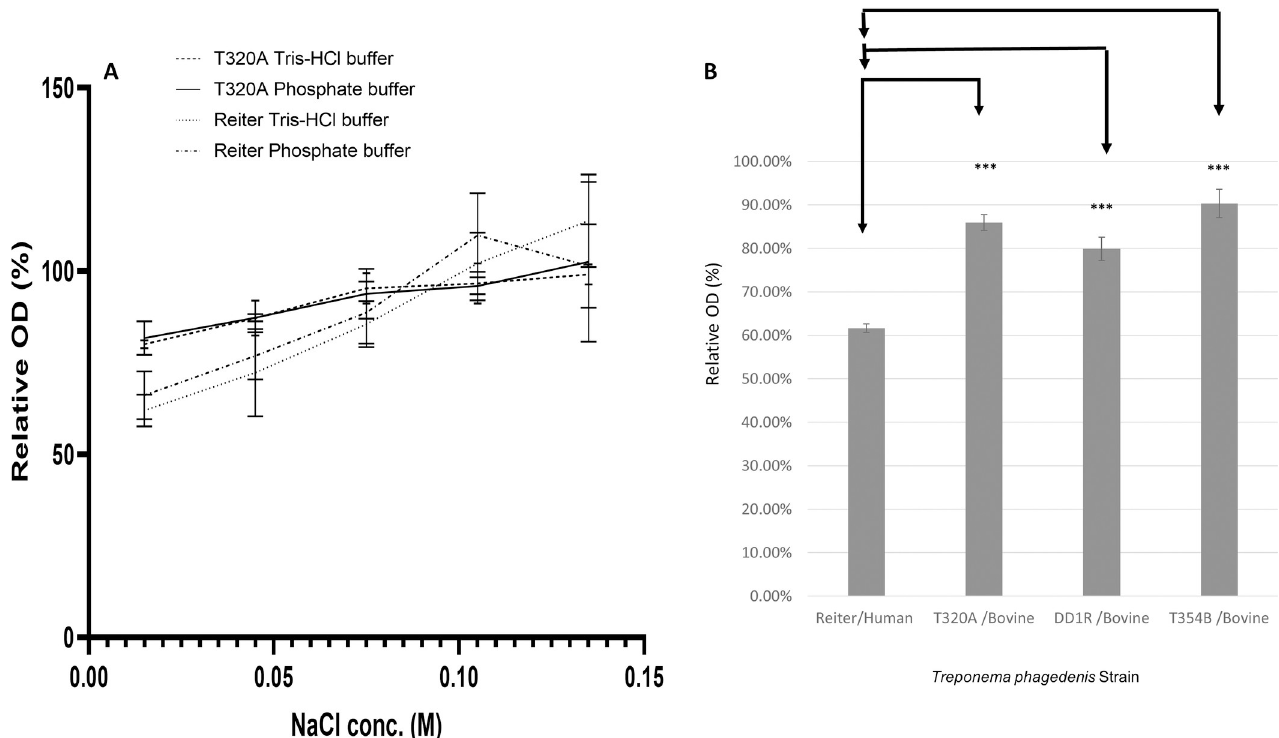
Fig 6. Survival of human and bovine strains of Treponema phagedenis when exposed to osmotic stress. Survival as determined by relative turbidity of human and bovine strains of T . phagedenis when suspended in solutions of NaCl below physiological concentrations (0.015 M, 0.045 M, 0.075 M, 0.105 M and 0.135 M) after 90 minutes incubation at 37 degrees C ( A ). Bars represent standard error of the mean. Data are representative of three experimental repeats undertaken on different days (each consisting of two technical replicates). Relative optical density of four T . phagedenis strains post-exposure to distilled deionised water for 90 minutes incubation at 37 degrees C ( B ). Bars represent standard error of the mean. Data are representative of four experimental repeats undertaken on different days (each consisting of three technical replicates).